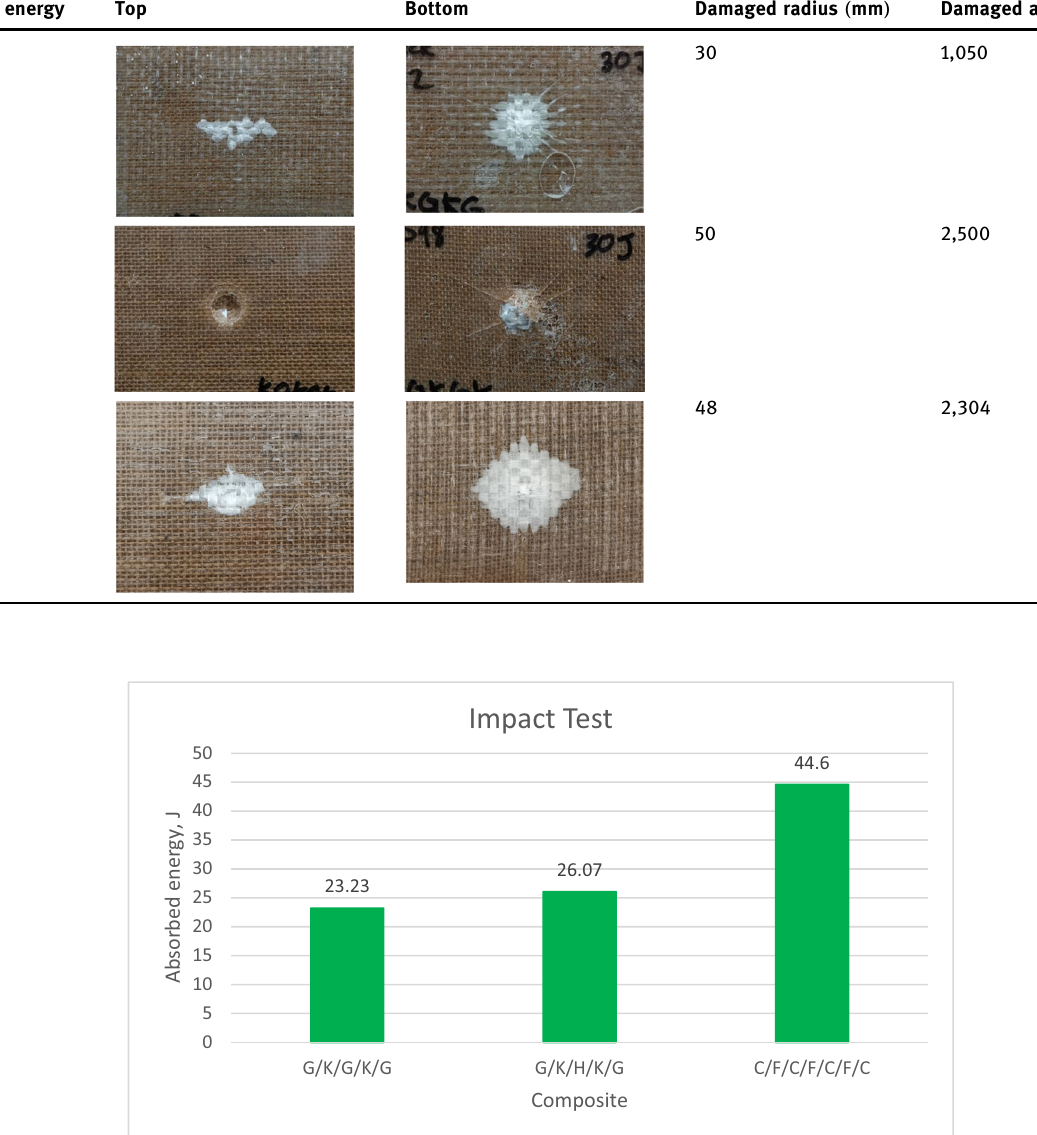
Table 3: Damage analysis of three types of composites Impact energy Top